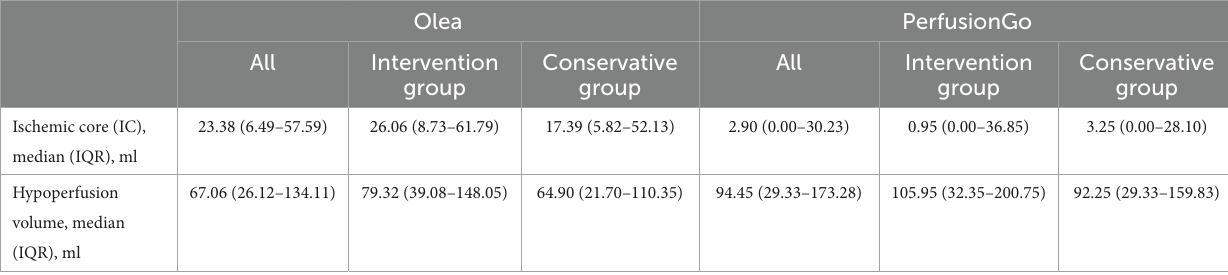
TABLE 2 Ischemic core (IC) and hypoperfusion volume estimated by the Olea and PerfusionGo